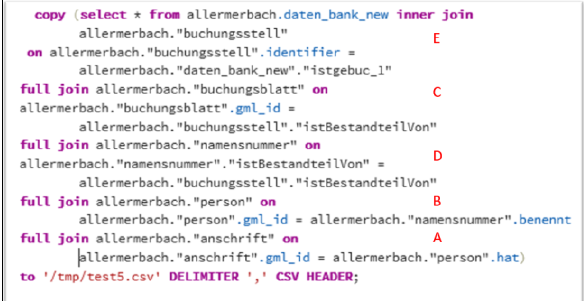
Figure 9: SQL code for automatic relational connection between the tables according to the specified relation